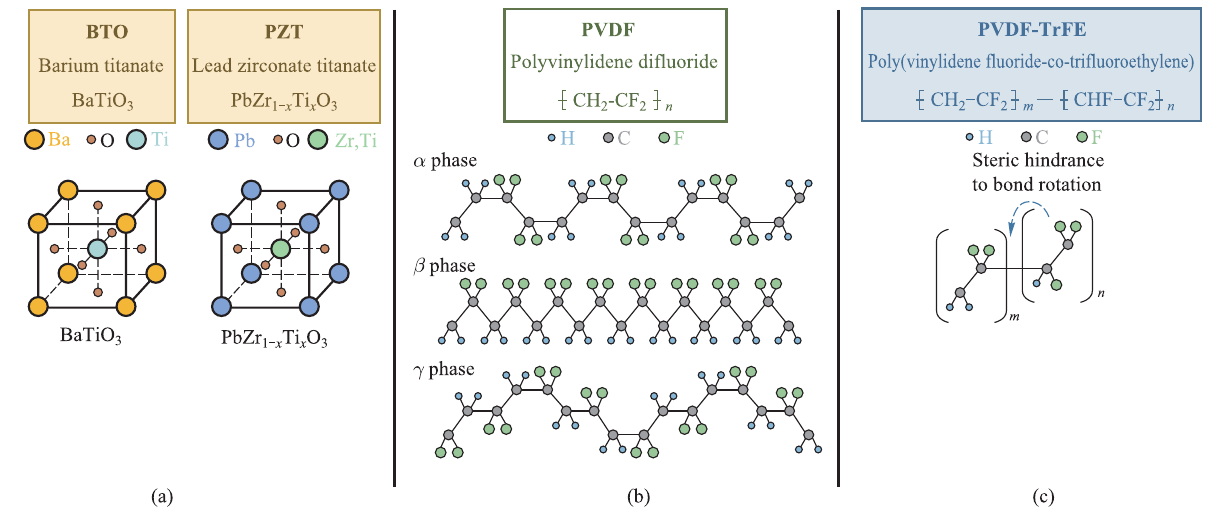
Fig. 4 Molecule structures of a BTO, PZT, b PVDF and c